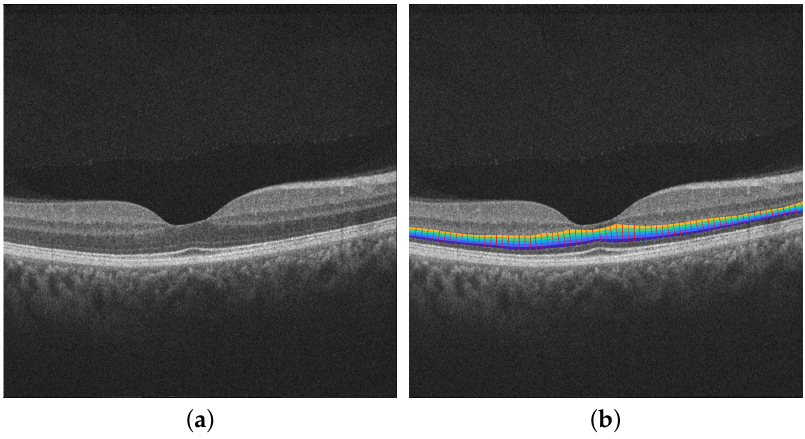
Figure 6. Original image ( a ) and the colored thickness map ( b ) between two retinal